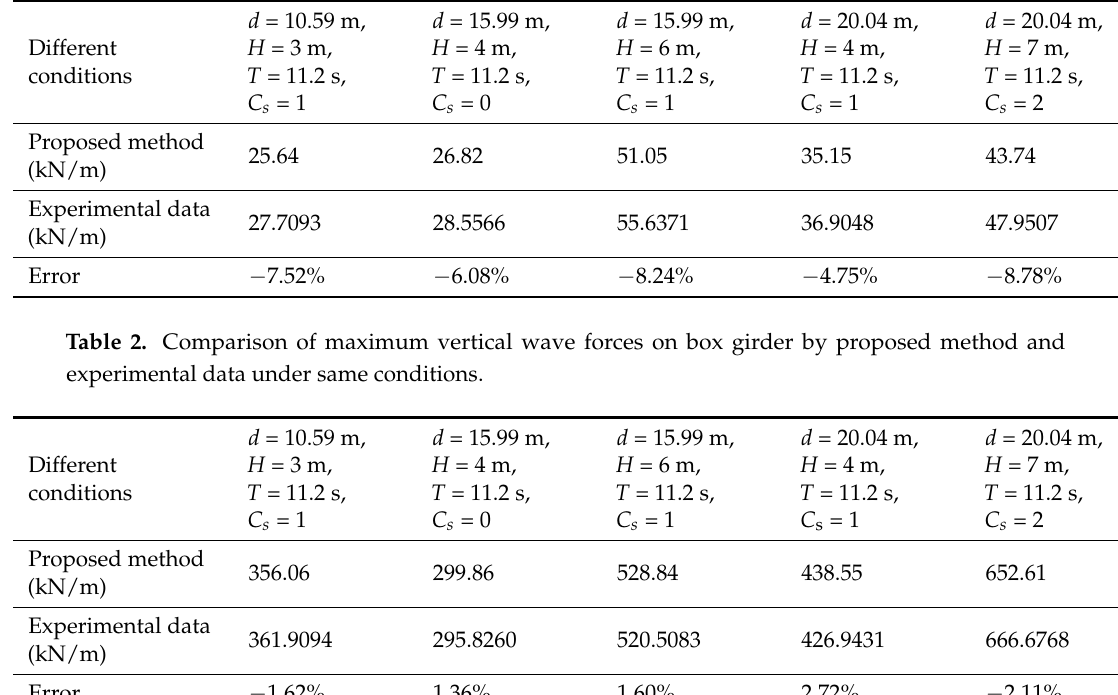
Table 1. Comparison of maximum horizontal wave forces on box girder by proposed method and experimental data under same conditions.